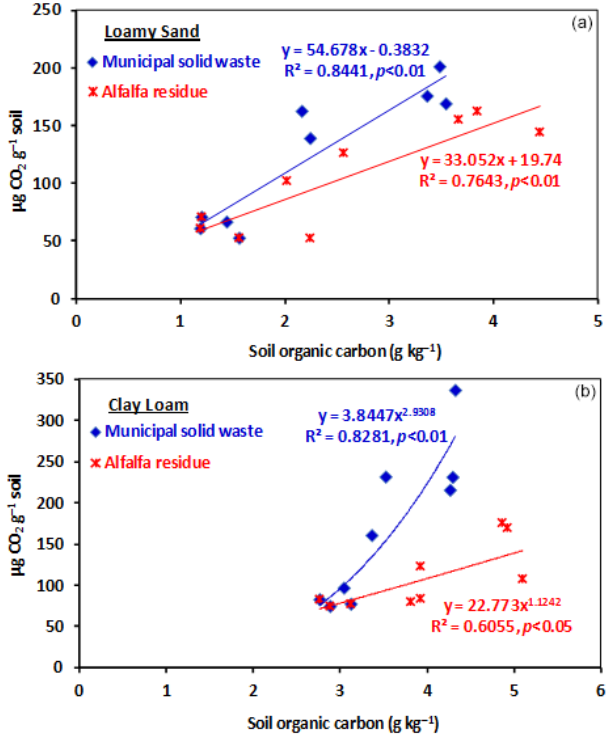
Figure 1. Relationship between the soil organic carbon and micro- bial respiration of loamy sand (a) and clay loam (b) soils, treated with different levels of municipal solid waste (MSW) and alfalfa residue